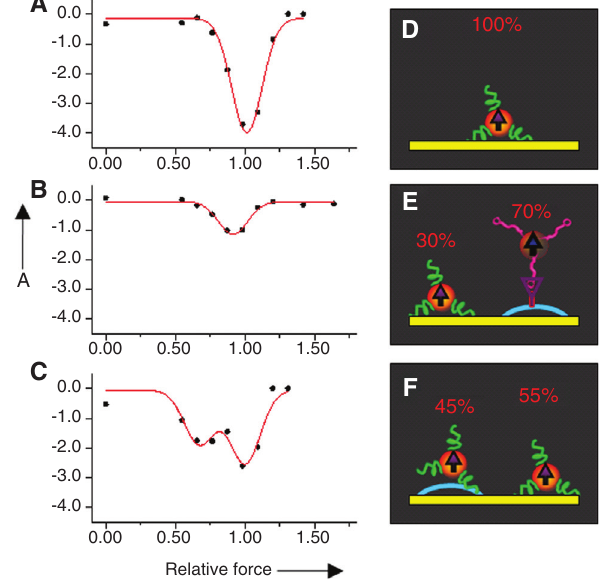
Figure 11 FIRMS spectra and peak assignments. (A, B, C) FIRMS spectra showing the magnetization differential as a function of disturbing force for (A) blank experiment with no cells but only CD3 antibody and magnetic particles in the sample, (B) cell-binding experiment, where CD3+ T cells were incubated with CD3 antibody and magnetic particles, (C) control experiment, where CD3+ T cells that were not conjugated with the CD3 antibody were incubated with magnetic particles. (D, E, F) Schematics of binding behaviors corresponding to the peaks shown in the FIRMS spectra; (D) phys- isorption of the magnetic particles onto the sample well; (E) 70% specific binding to the target cells; (F) 45% non-specific binding of the magnetic particles on the cell surface. (Reproduced with permis- sion from Ref. [165], Copyright John Wiley and Sons,